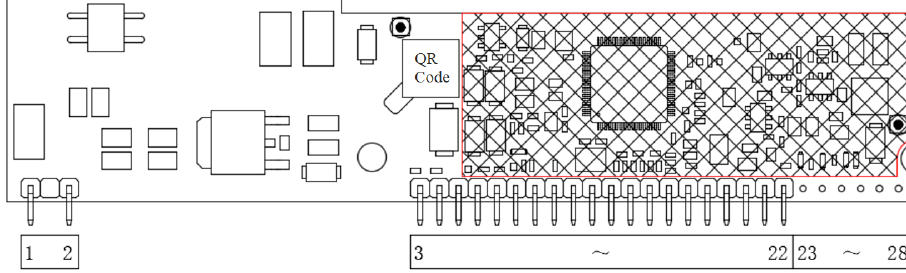
Figure 12. Interface labeling diagram of HPLC topology module for measurement switch. Table 3. Main interface definition and description of HPLC topology module for measurement switch.